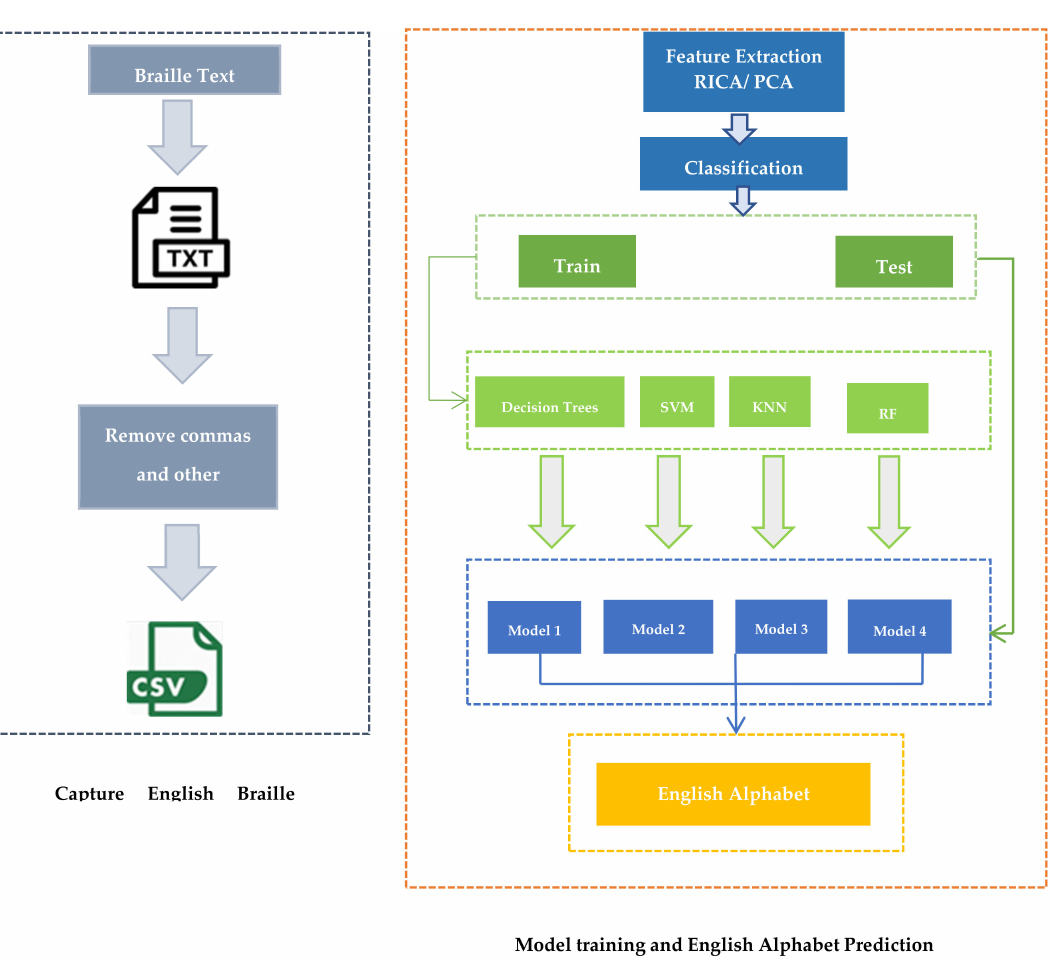
Figure 1. Schematic